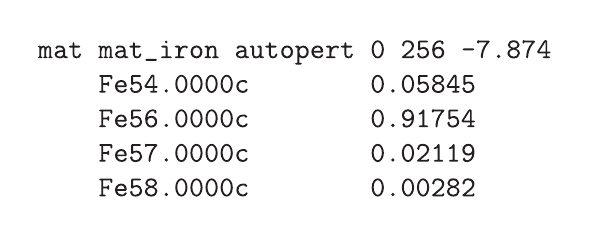
Fig. 2. Iron material definition with 256 different ACE files.